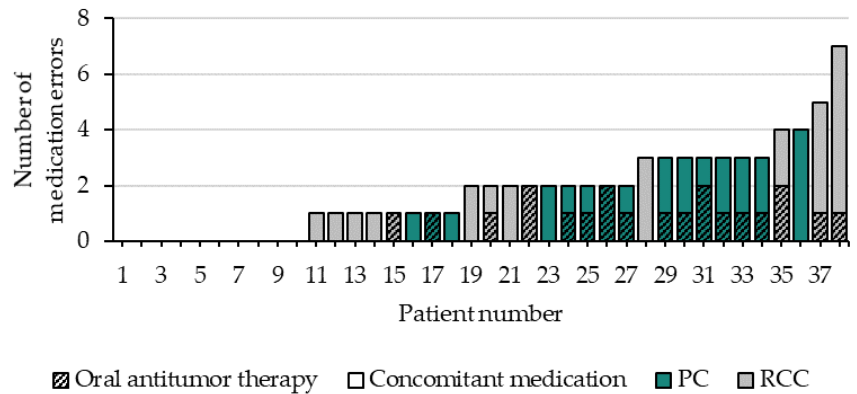
Figure 1. Number of medication errors in patients with PC or RCC treated with new oral antitumor drugs within the first 12 weeks of therapy stratified for the involved type of medication (oral antitumor therapy or concomitant medication) and the tumor entity. Abbreviations: PC = prostate cancer; RCC = renal cell carcinoma.